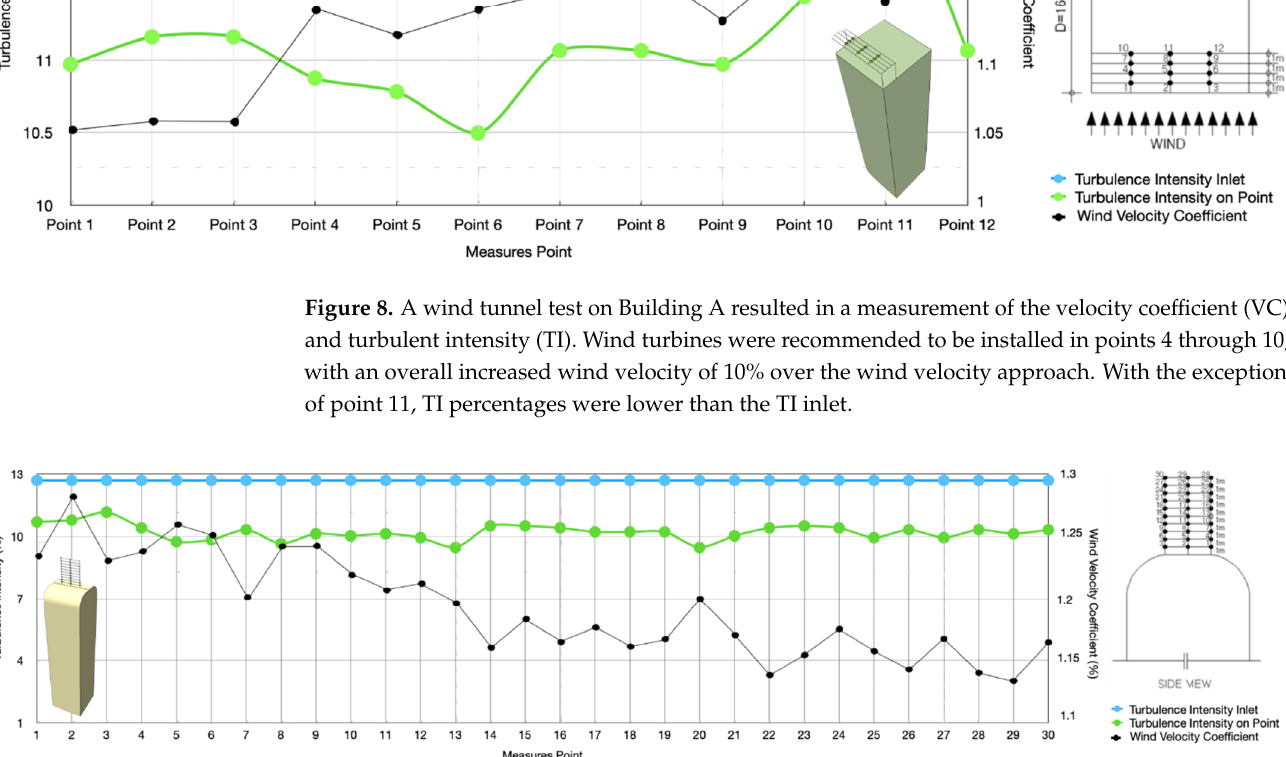
Figure 10. A wind tunnel test on building C resulted in a measurement of the velocity coefficient (VC) and turbulent intensity (TI). The ½ round shape can produce wind velocity up to 34% greater than other shapes. In this model, wind turbines should be installed in the 1 m to 2 m height above the ½ rounded shapes. The ½ round shape can produce wind velocity up to 34% greater than other shapes. When compared with other models, building C had the best performance. In this model, wind turbines should be installed in the 1 m to 2 m height above the ½ rounded shape. Keeping the wind turbine tower lower can increase wind velocity with a fully rounded shape. 4. Comparison of Wind Tunnel Results with Computer Simulation A comparison with CFD analysis from previous results was also performed to obtain a better understanding of wind flow [18,28]. A combination of these methods was used to validate the model’s results. In comparison to a regular experiment, the CFD provides